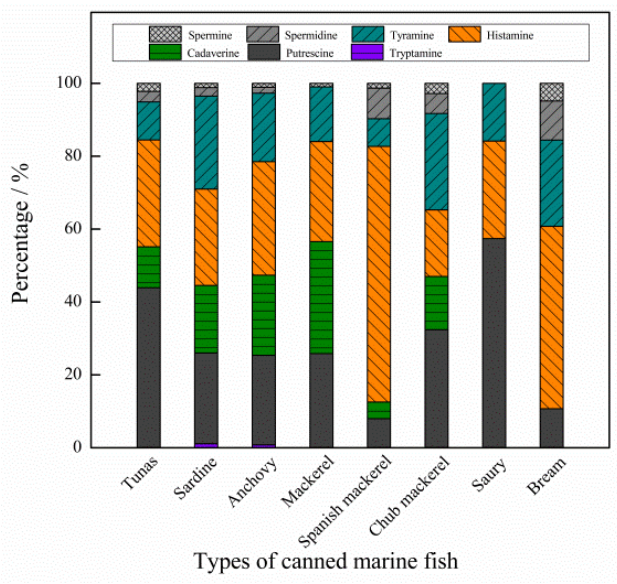
Figure 6. Percentage of 7 kinds of biogenic amines.